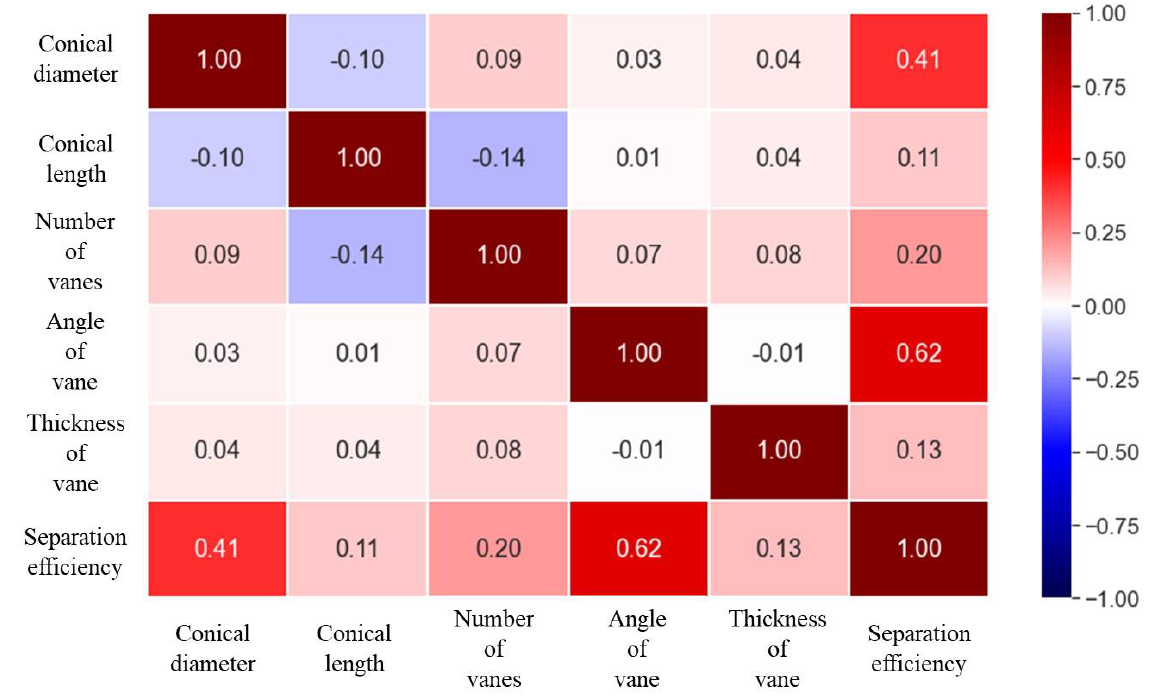
Figure 8. Pearson correlation coefficient heat map of separation efficiency between five design pa- rameters.